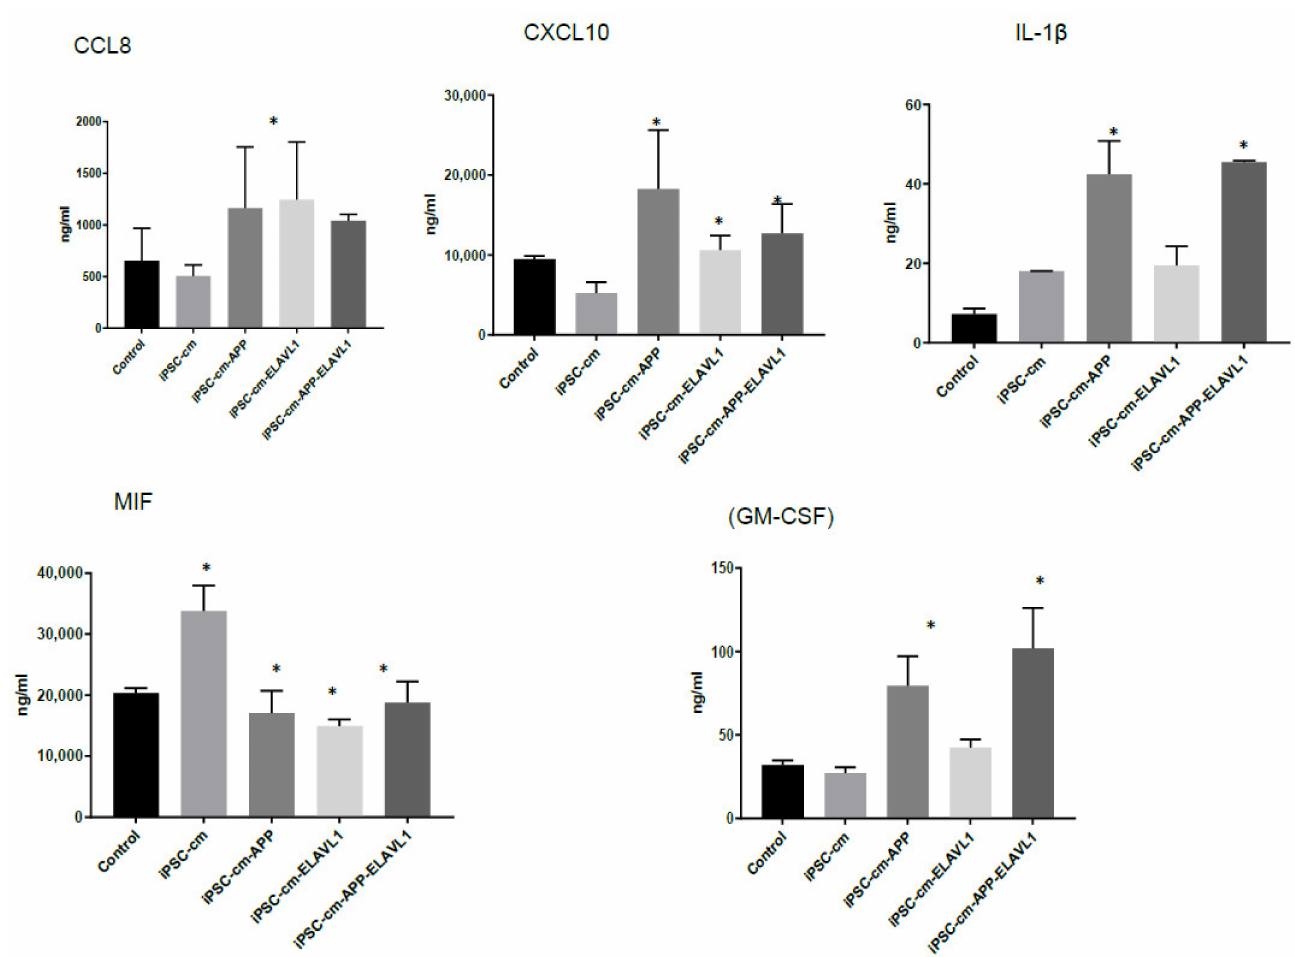
Figure 4. Cytokine profile of M2a macrophages after iPSC-CM treatment, as measured by Multiplex assay. Values represented as Mean ± SEM; *: p <